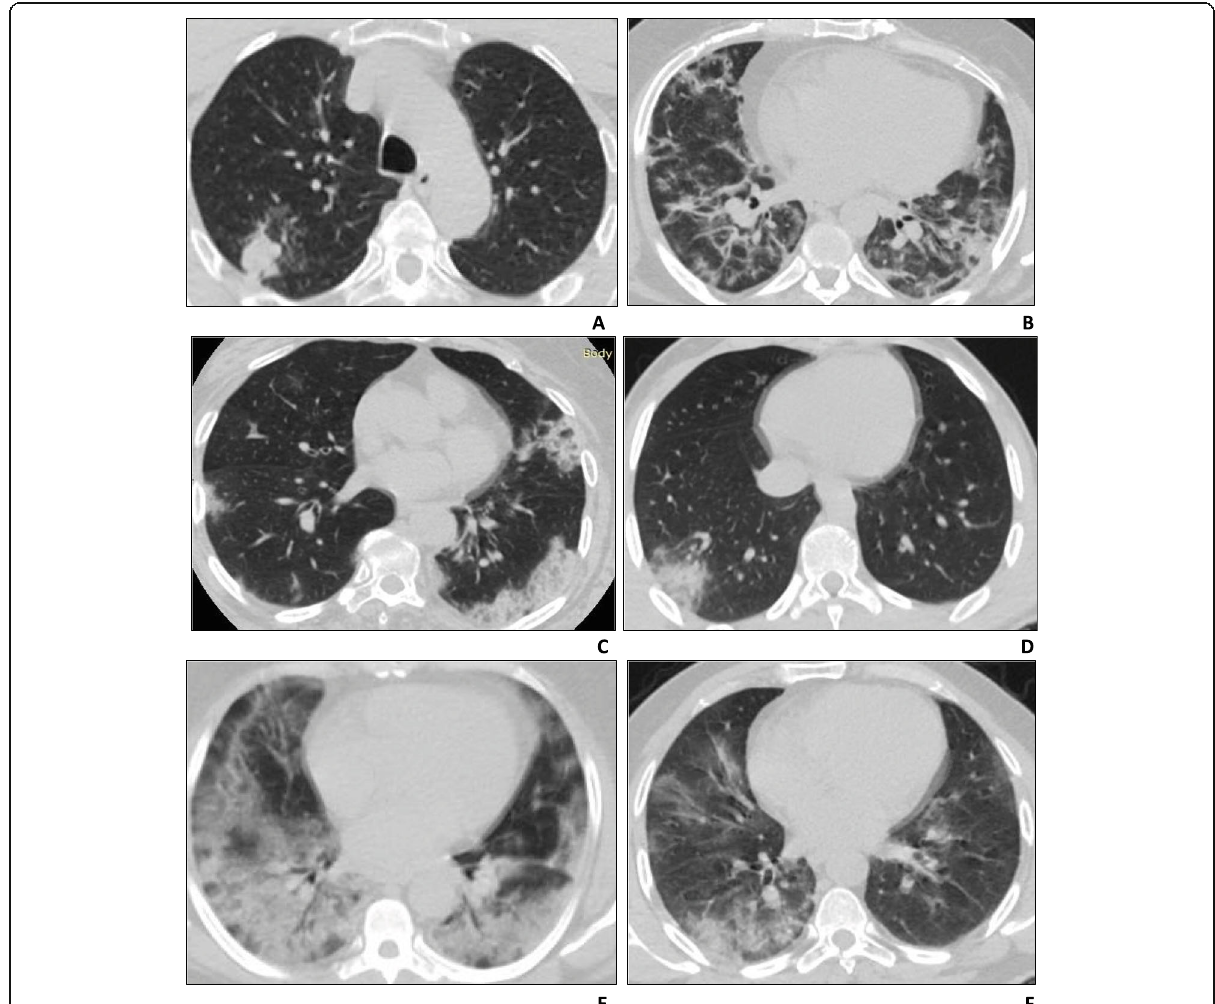
Fig. 5 Different shapes of consolidation. a Round consolidation. b Arcade-like consolidation. c Peripheral consolidation parallel to the pleura. d Wedge-shaped consolidation. e Lobar consolidation with air bronchogram. f Irregular patchy